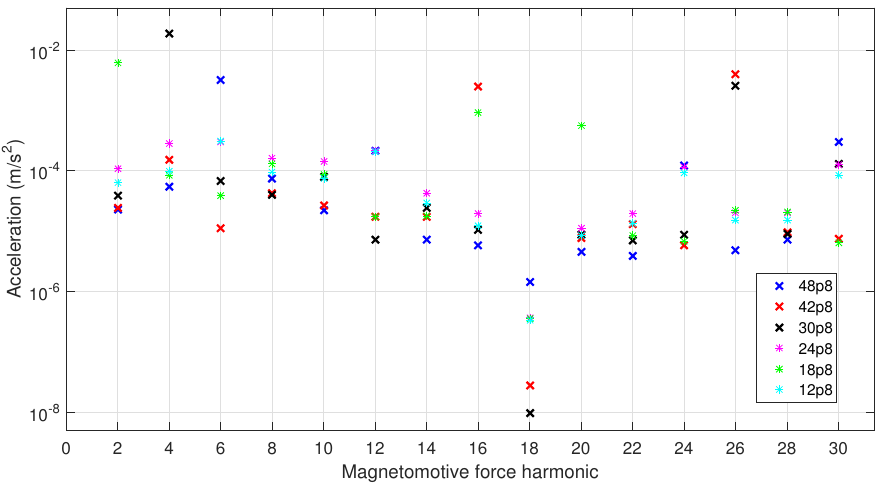
Figure 8. Comparison of the vibration response of machines of several numbers of slots and 8 pole